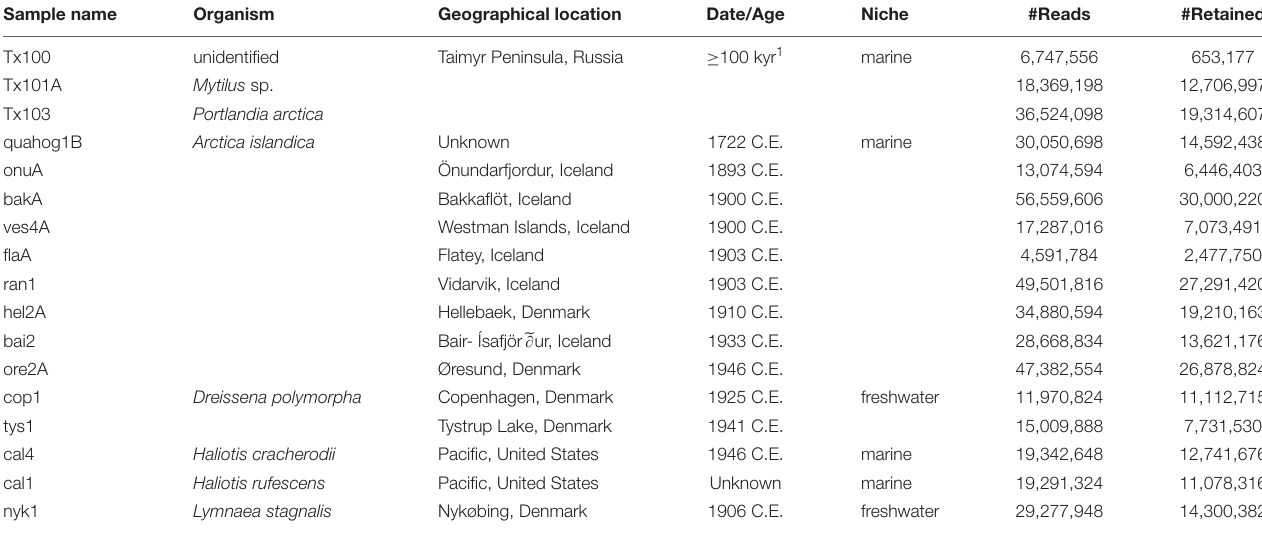
TABLE 1 | Sample information and sequencing